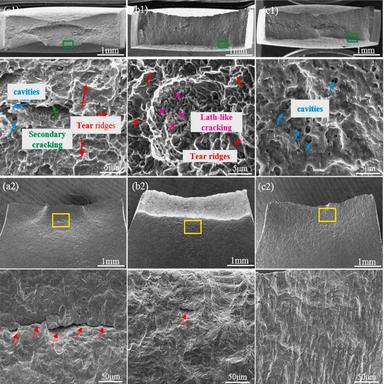
Cross sectional (1) and side (2) morphologies of fracture for steel samples in the simulated solution at OCP (a) TMCP steel, (b) DQ steel, and (c) QT steel.